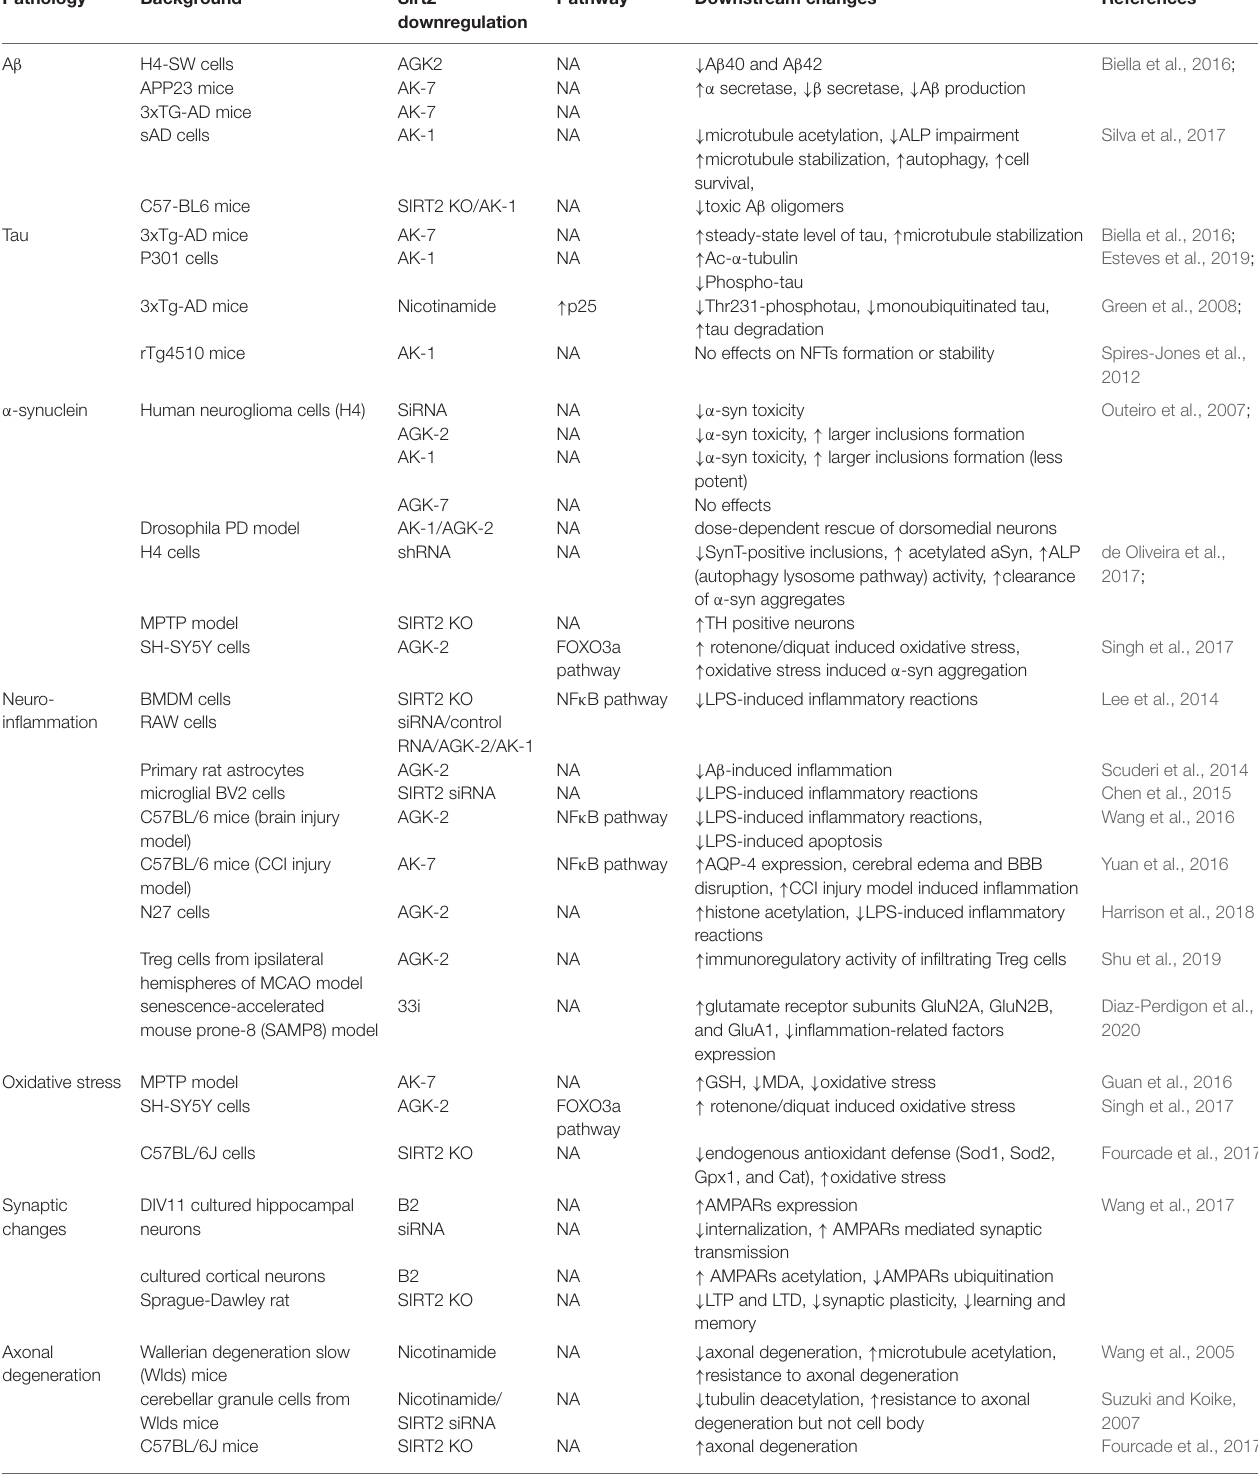
TABLE 1 | Relationship between SIRT2 and